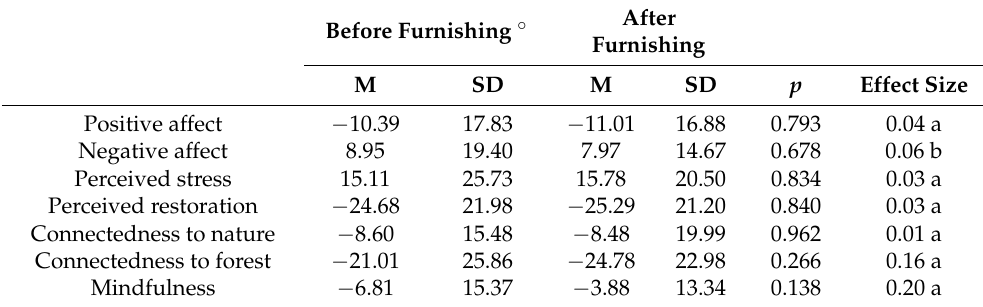
Table 3. Comparison of changes in participants’ self-perceptions.